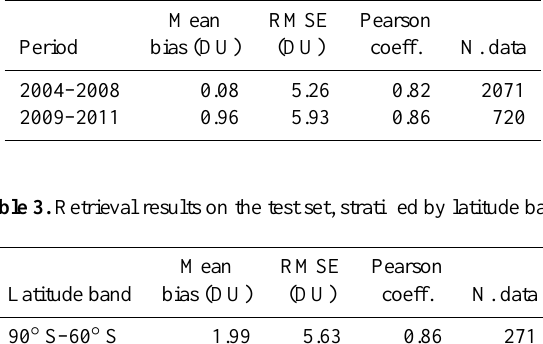
Table 2. Retrieval results during and after the period covered by the training set. The training set covers the period from 2004 to 2008. Mean RMSE